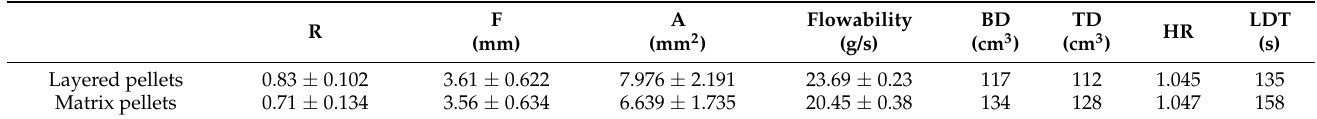
Table 3. Results (mean ± SD) of image analysis, flowability and compressibility measurements of pellet formulations. R = Roundness ( n = 200), F = Maximum Feret diameter ( n = 200), A = Projected Area ( n = 200), FR = Flow Rate ( n = 3), BD = Bulk Density, TD = Tapped Density, HR = Hausner ratio, LDT = Longest Disintegration Time.